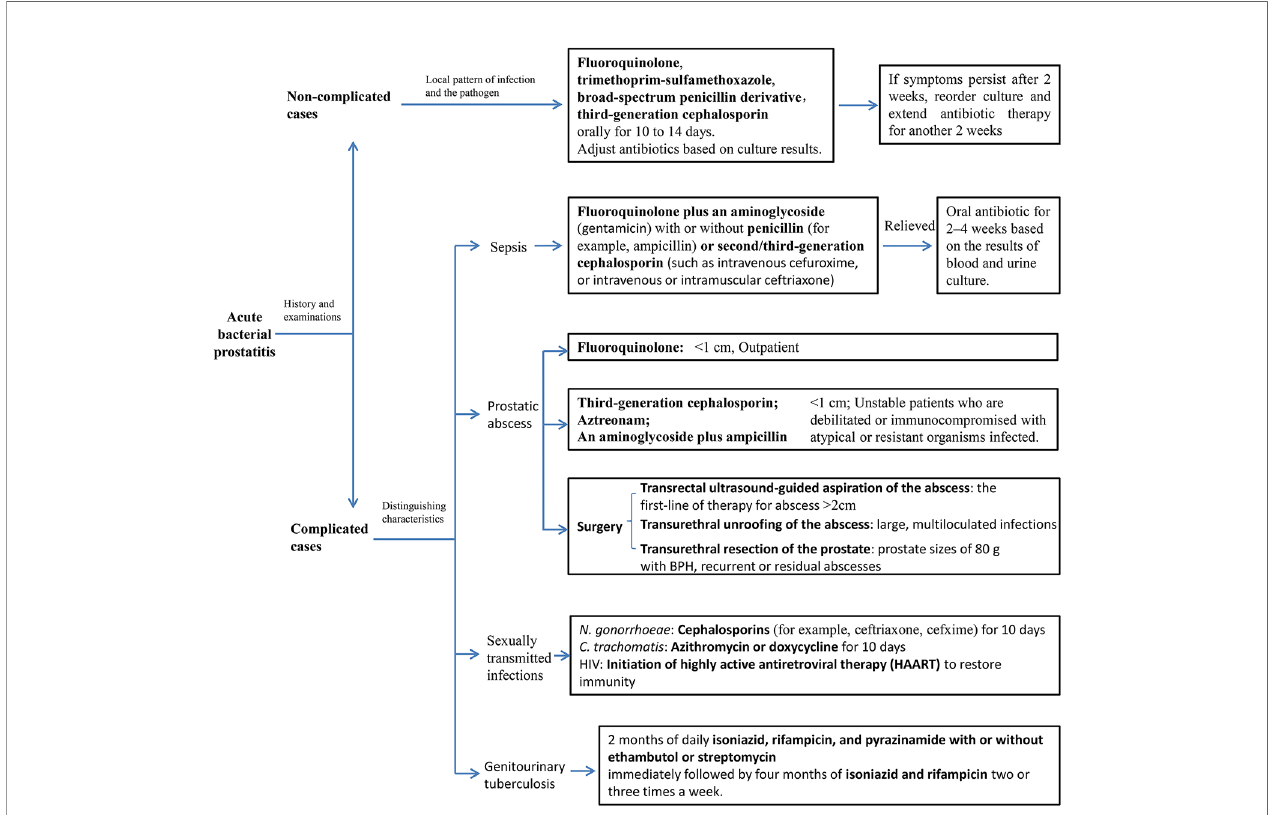
FIGURE 1 | Treatment algorithm for acute bacterial